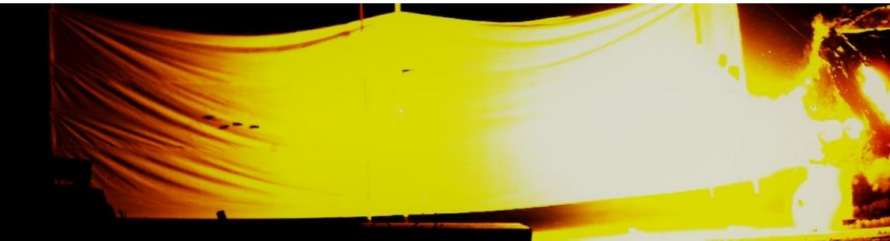
Figure 11. High-speed photography screenshots of the seventh dynamic test